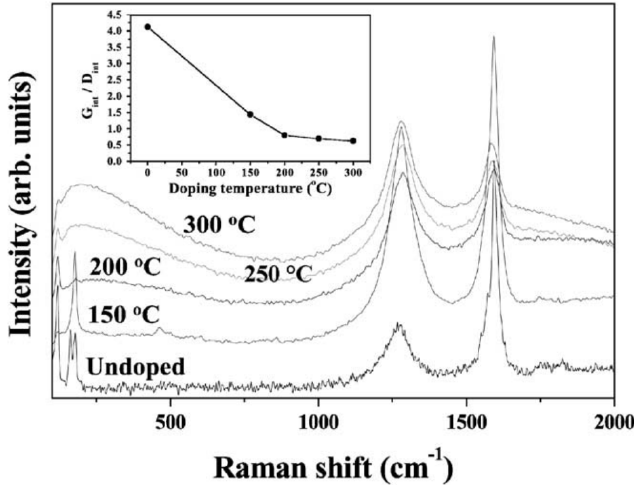
Figure 6. The Raman spectra of the pristine SWCNTs and the nanotubes fluorinated at 150, 200, 250 and 300 °C. The inset shows the dependence of the intensities of G and D modes on the doping temperature. Reprinted with permission from Ref. [48]. Copyright 2003 Elsevier.